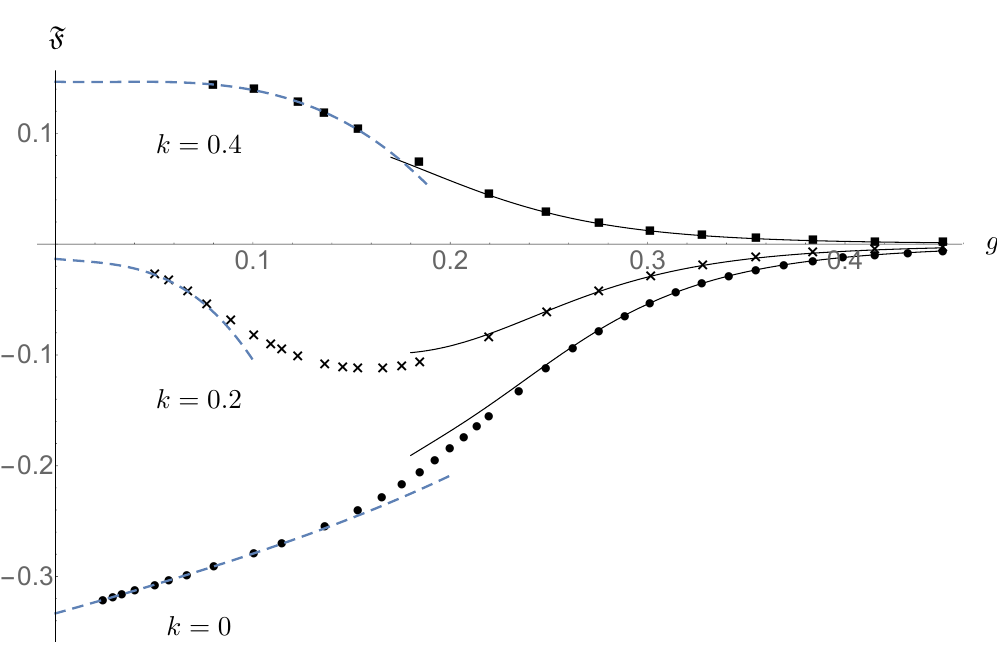
Figure 8 . A plot of F ( r; k ) with k = 0 ; 0 : 2 and 0 : 4 as a function of the running coupling constant g ( r ) (5.37) for the O (3) sigma model. The large- r asymptotics, depicted by the black curves,